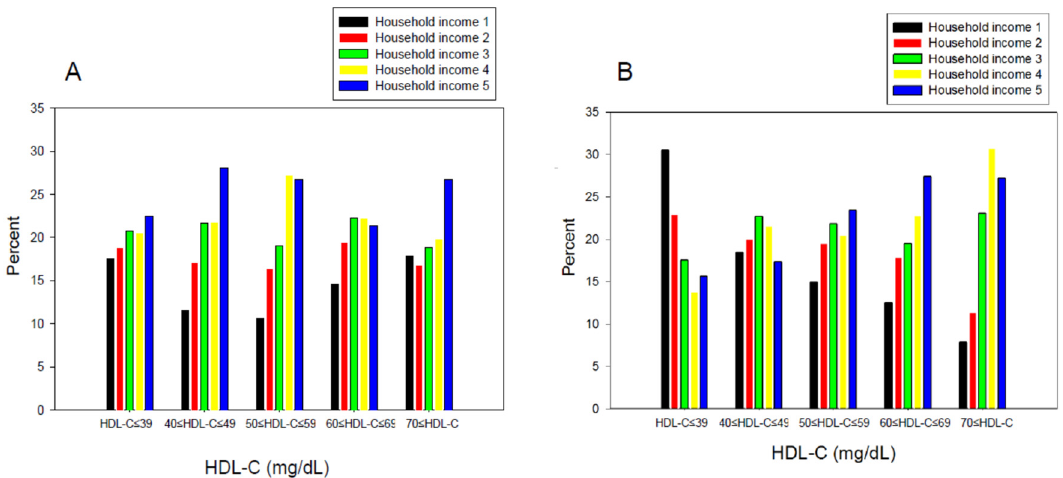
Figure 3. Distribution of household income grade percentage, according to the high-density lipoprotein cholesterol (HDL-C) category in men ( A ) and women ( B ): KNHANES 2017. cholesterol (HDL-C) category in men ( A ) and women ( B ): KNHANES